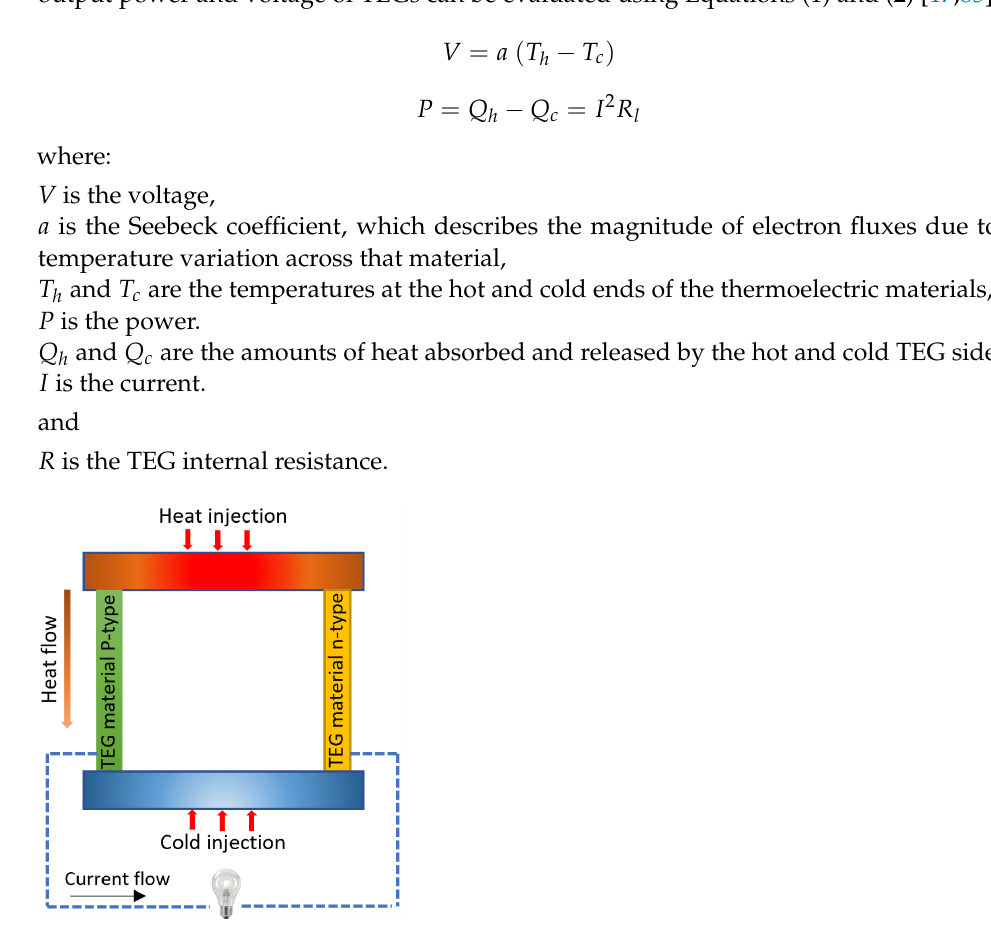
Figure 11. Schematic view of the thermoelectric materials and electric voltage producing process [17,84]. (This drawing was created by the authors).